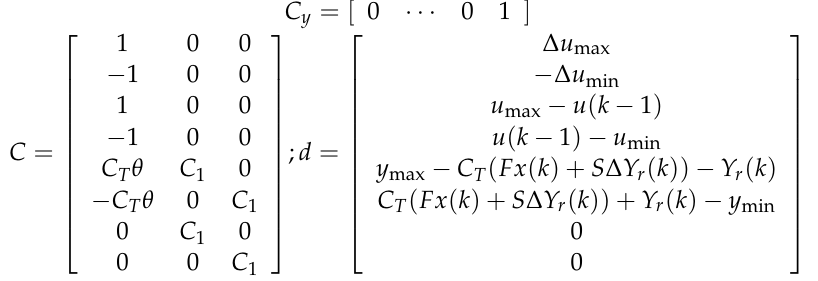
Table 1. The main differences between the two strategies. Model Extended state space model Constraints Performance